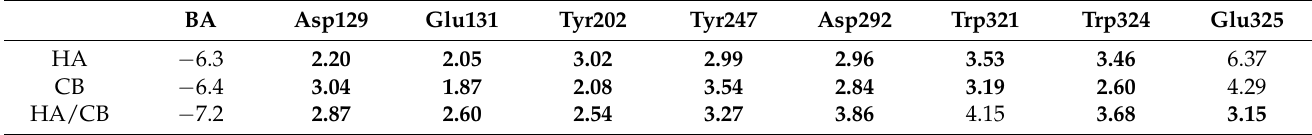
Table 5. Binding affinity (BA) in kcal · mol − 1 computed for HA-CB, HA, and CB bound to hHyal-1 and key distances in Å between Hyal-1 amino acids and ligands. Hydrogen bonds are marked in bold.